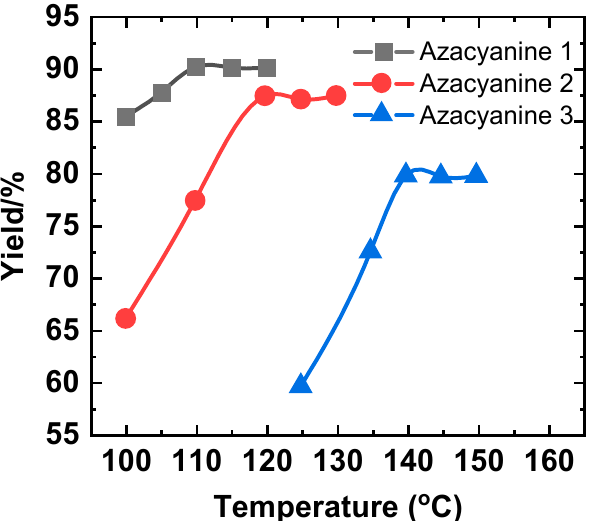
Figure 2. The effect of temperature on the yield of target products: Azacyanine 1 (black), Azacyanine 2 (red), and Azacyanine 3 (blue).